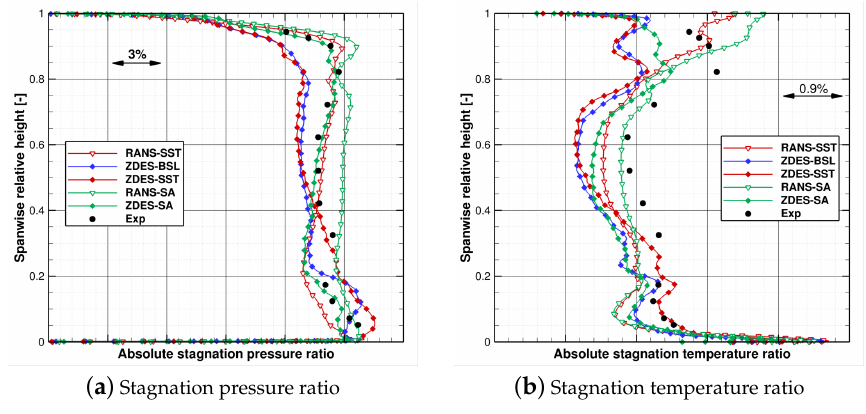
Figure 6. Stagnation pressure and temperature ratios between planes 25A (upstream) and 26A